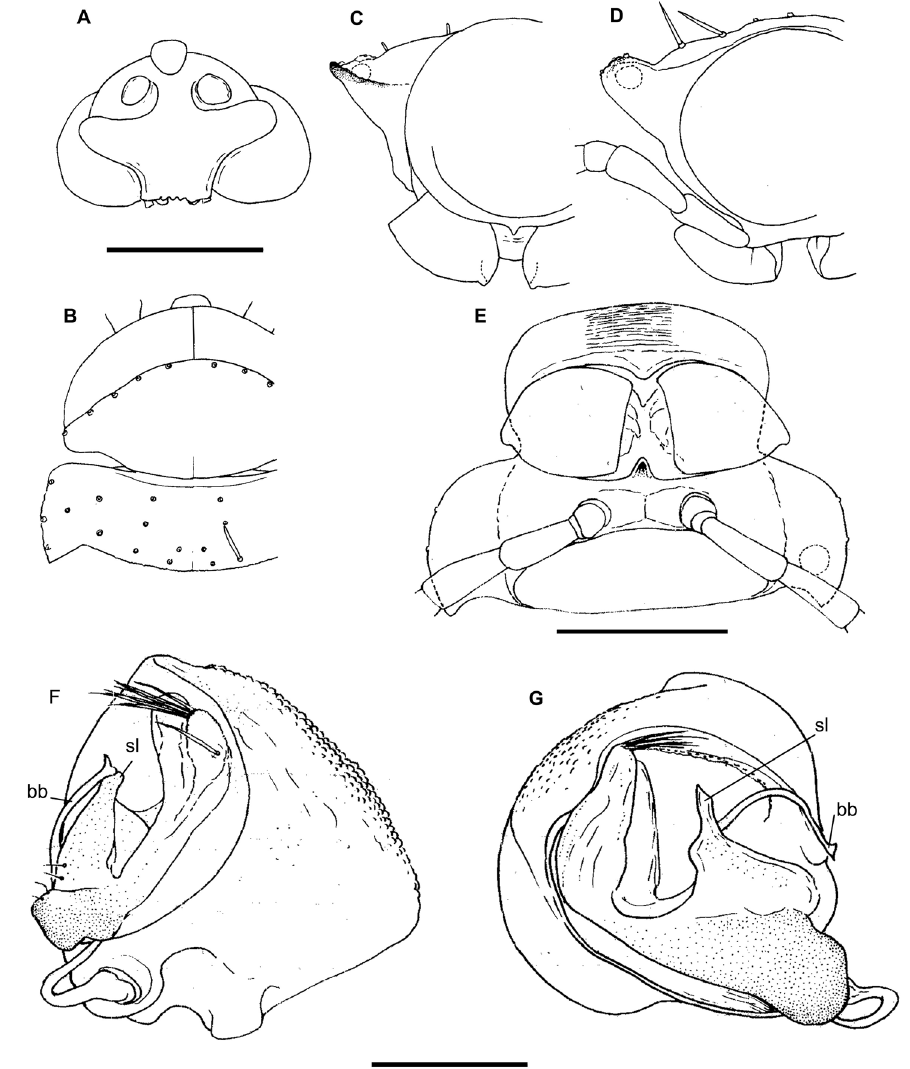
Figure 27. Hemisphaeroparia integrata (Porat, 1894), ♂ lectotype A head, ventral view B anterior part of body, dorsal view C, D, E segment 7 with gonopods, oral, caudal and ventral views, respectively F, G right gonopod, mesal and ventromesal views, respectively. Scale bars: 0.5 mm ( A–E ), 0.1 mm ( F, G ). Figures by JPM, inked by M.